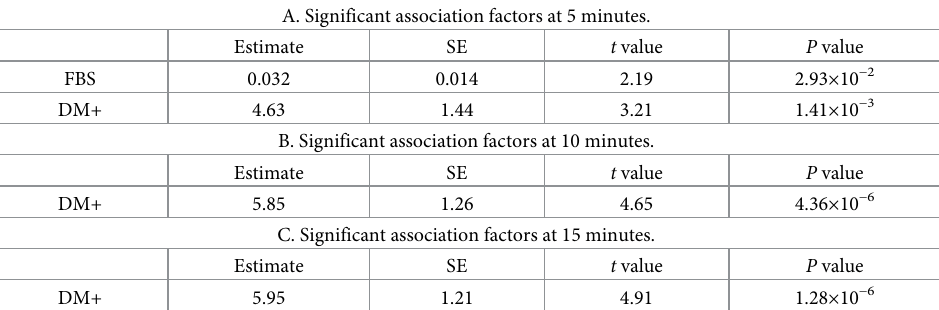
Table 3. Results of stepwise multiple regression analysis for a pulse rate. Explanatory variables including age, gen- der, BMI, FBS, eGFR, pre-operative SBP/DBP and PR, the presence or absence of DM and the presence or absence of hypertension medication.